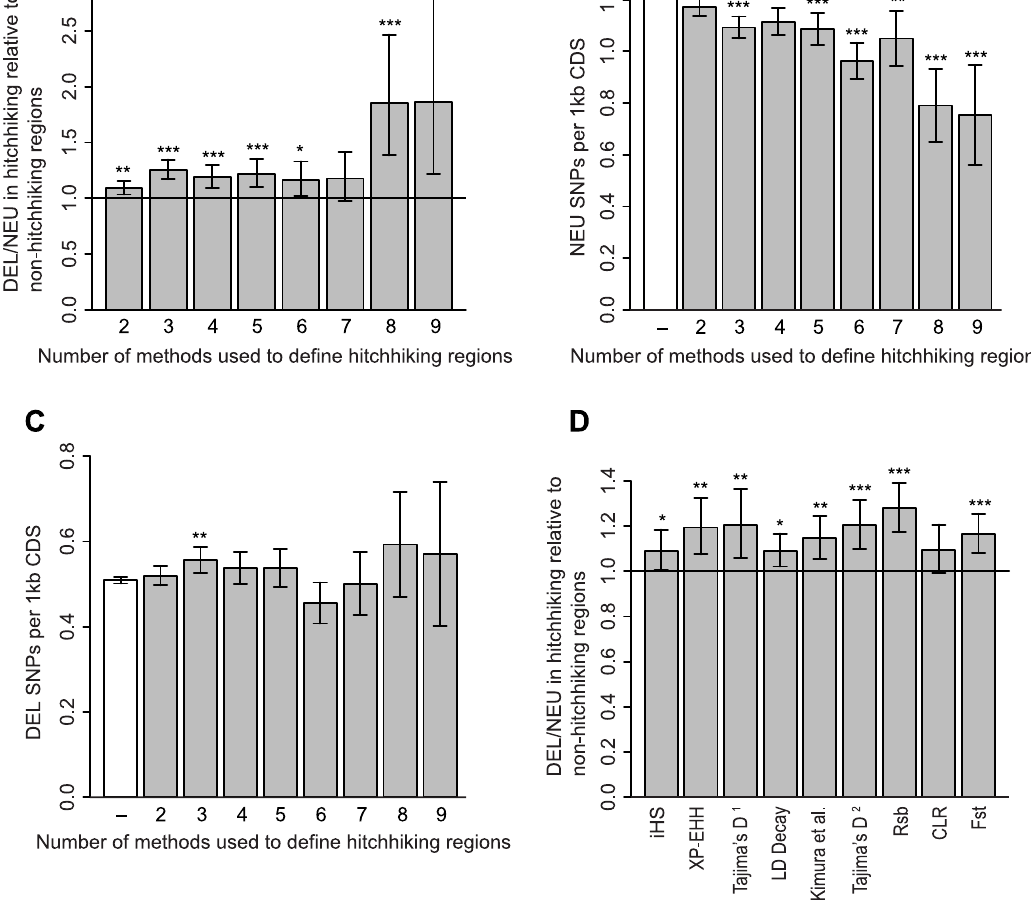
Figure 3. Rates of deleterious and neutral SNPs in hitchhiking and non-hitchhiking regions. The ratio of deleterious (DEL) to neutral (NEU) SNPs is higher in hitchhiking relative to non-hitchhiking regions (A). The rate of neutral SNPs is reduced (B) and the rate of deleterious SNPs remains relatively constant (C) in hitchhiking compared to non-hitchhiking regions. The x-axes in panels A–C denotes the minimum number of methods used to define hitchhiking regions. Non-hitchhiking regions are labeled by a dash (–). The ratio of deleterious to neutral SNPs is higher in hitchhiking to non-hitchhiking regions for the majority of tests of selection (D). Tajima’s D was used by two studies: [76] 1 and [77] 2 . Bars show 90% confidence intervals, one, two and three stars indicate P , 0.05, P , 0.01, and P , 0.001 based on a one-sided Fisher’s Exact